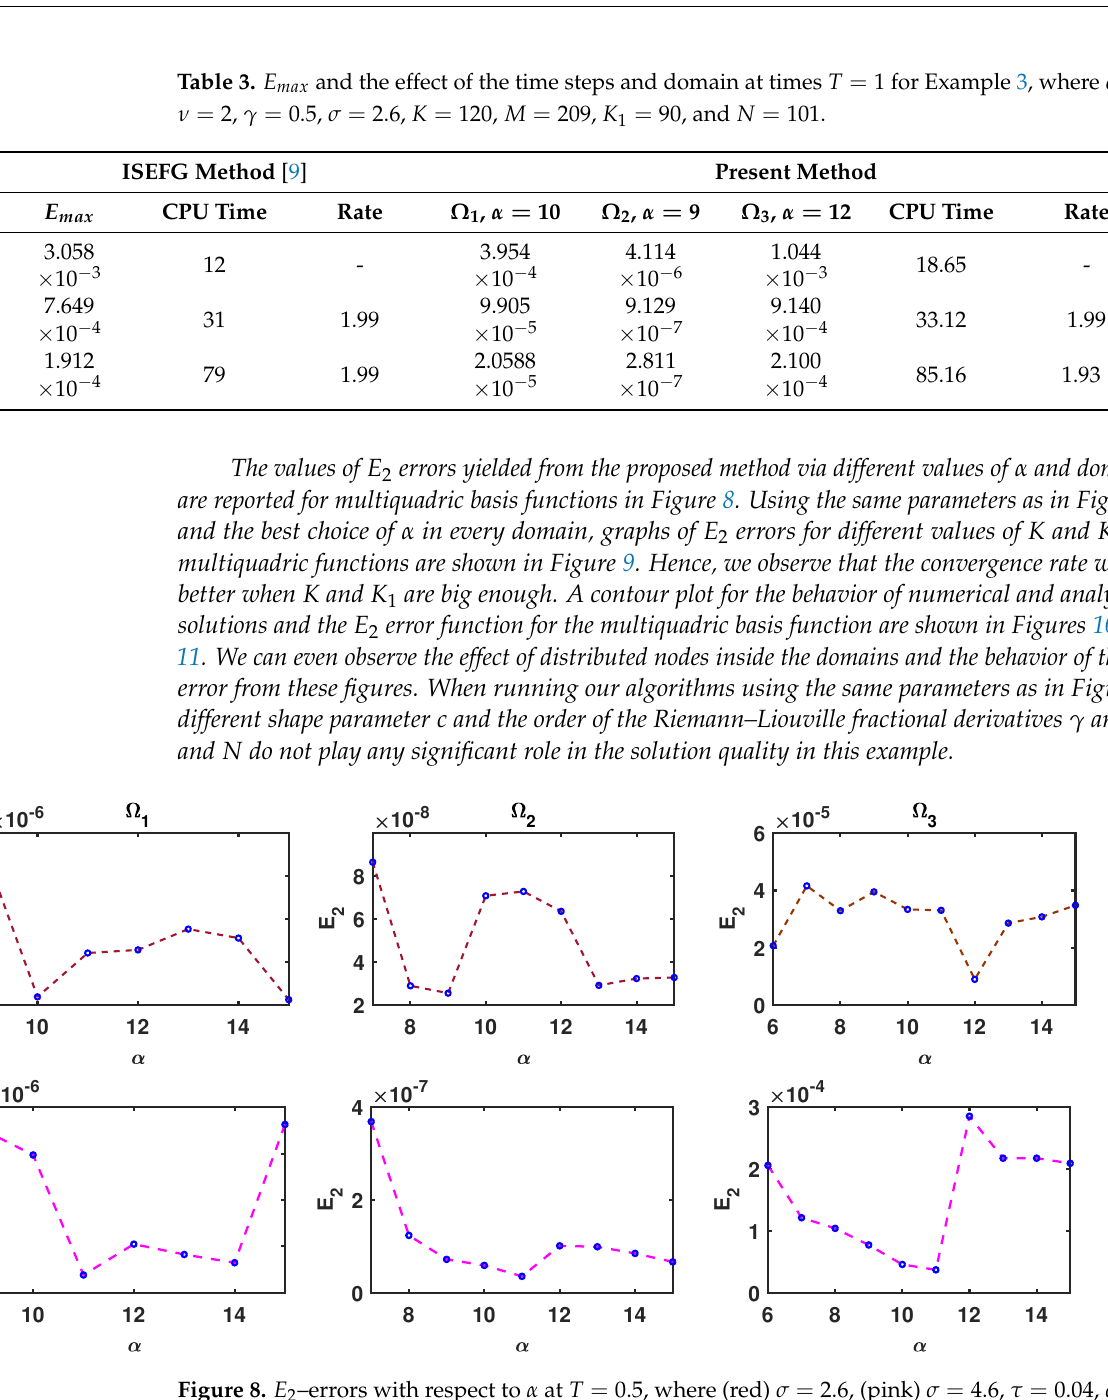
Figure 8. E 2 –errors with respect to α at T = 0.5, where (red) σ = 2.6, (pink) σ = 4.6, τ = 0.04, c = 5, ν = 2, γ = 0.5, K = 120, K 1 = 90, M = 228, and N = 101 for Example